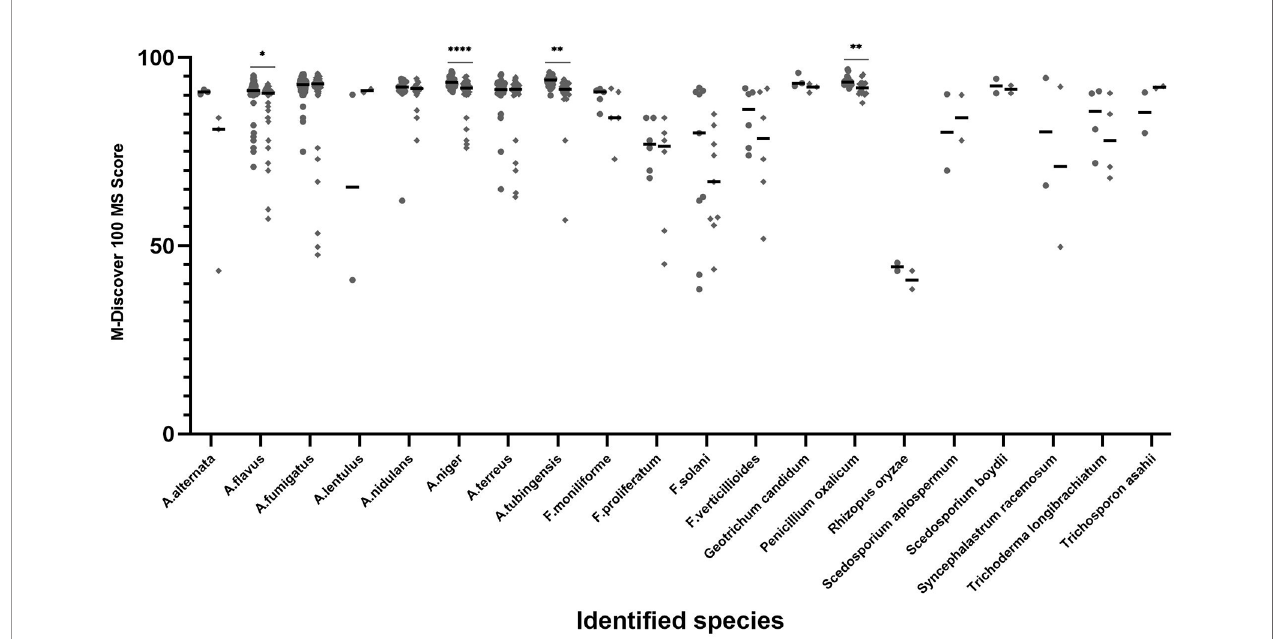
FIGURE 2 | Average score and distribution by M-Discover 100 with the in-house library by method performed. Each dot represents the score for each isolate identi fi cation achieved by the ZSB (round dots) and routine (diamond dots) methods. Horizontal bars represent the mean identi fi cation score achieved by each method for each species including at least two isolates. A paired t-test was performed to analyze differences between the ZSB method and the routine method, and statistical signi fi cance was de fi ned by p values less than 0.05 (* p < 0.05, ** p < 0.01, **** p <